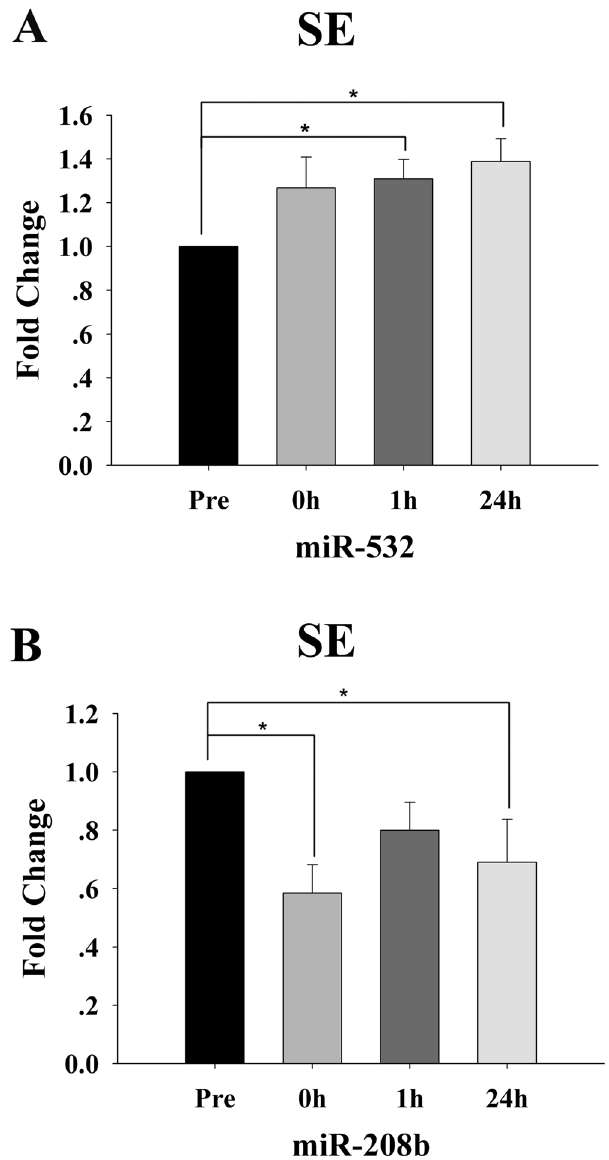
Figure 3. Time-course changes in the plasma levels of miR-532 ( A ) and miR-208b ( B ) for the resistance endurance (SE) protocol (n = 15). For each subject, the c-miRNA levels at baseline (Pre) were assigned a fold change of 1, and measurements obtained immediately after exercise (0 h), after 1 h of recovery (1 h) and after 24 h of recovery (24 h) were compared to the baseline. * Indicates differences compared to Pre, p < 0.05. Values represent the mean ±